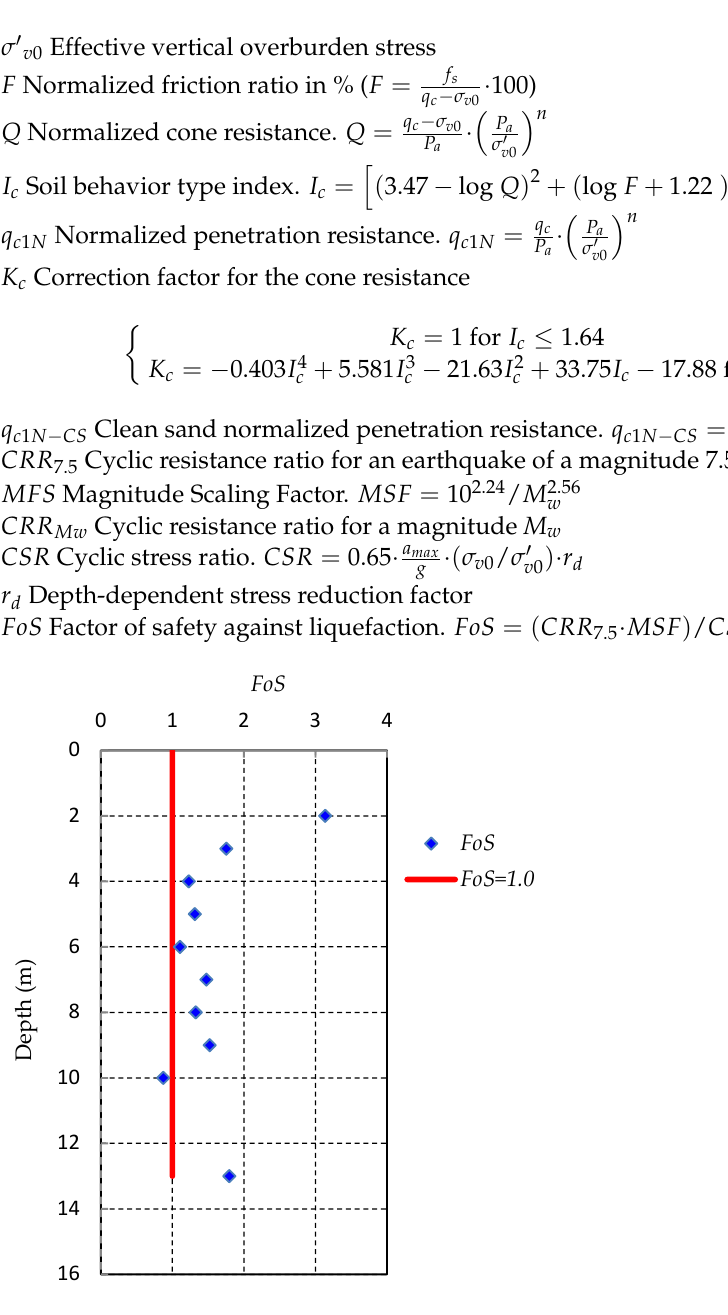
for the simulated earthquake. Figure 4. Factor of safety FoS for the simulated 𝐹𝐹𝐹𝐹𝐹𝐹